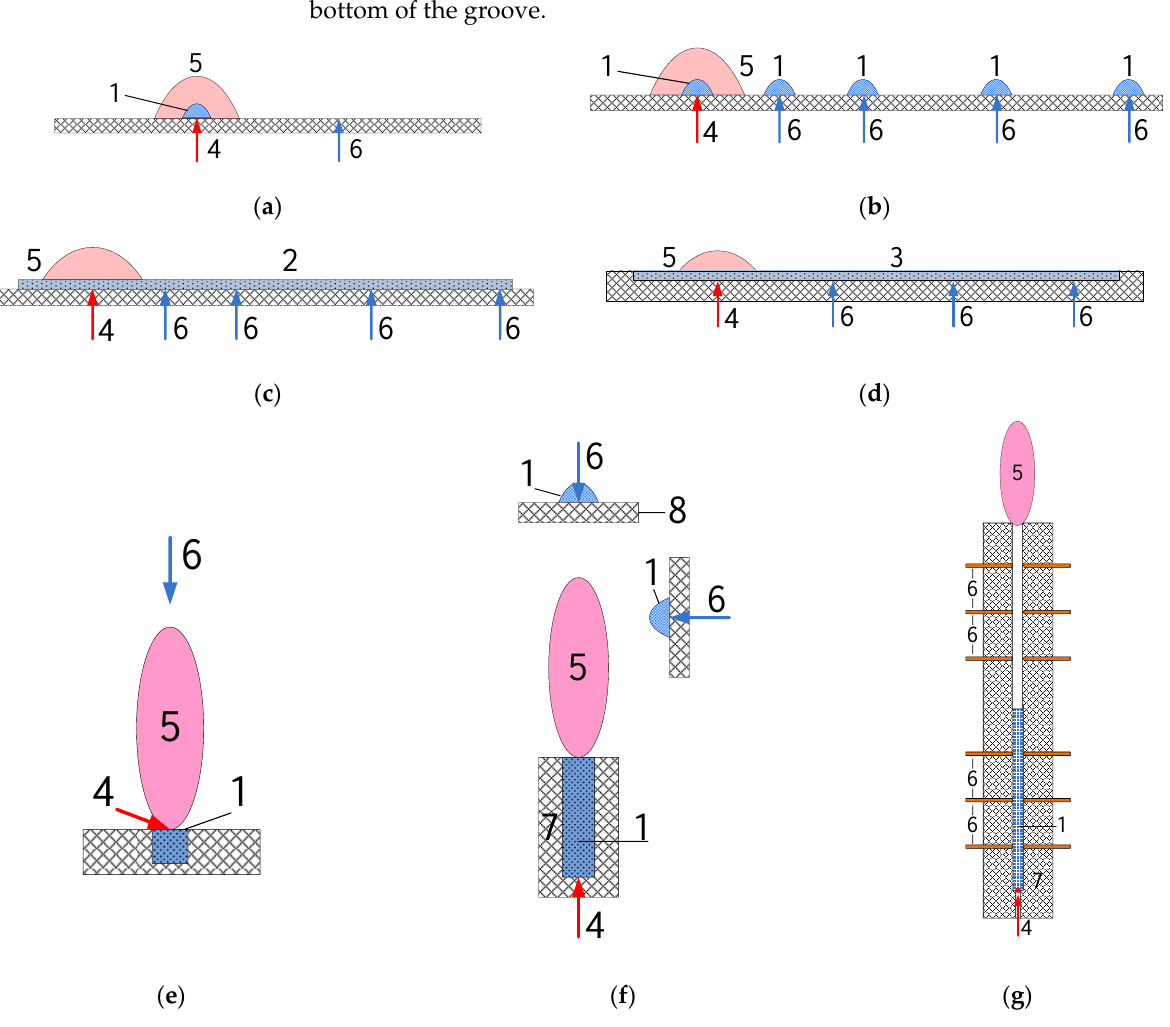
Figure 2. ( a – g ) Various schemes of experimental assemblies for the formation of a flame of a thermite mixture. 1 — the sample, 2 — linear sample of thermite mixture, 3 — the thermite mixture in the groove, 4 — spark, 5 — the flame, 6 — electrical sensors, 7 — the shell, 8 — the target.